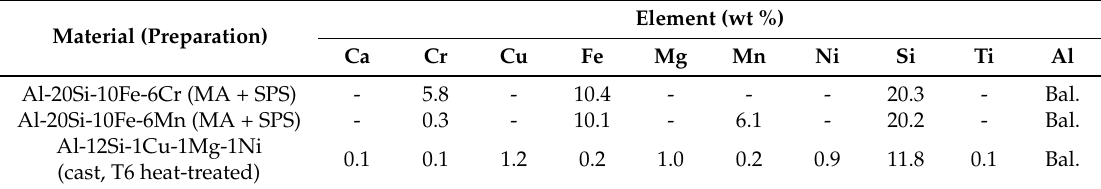
Table 4. Chemical compositions (wt %) of the MA + SPS alloys and of the reference as-cast AlSiCuMgNi material measured by XRF